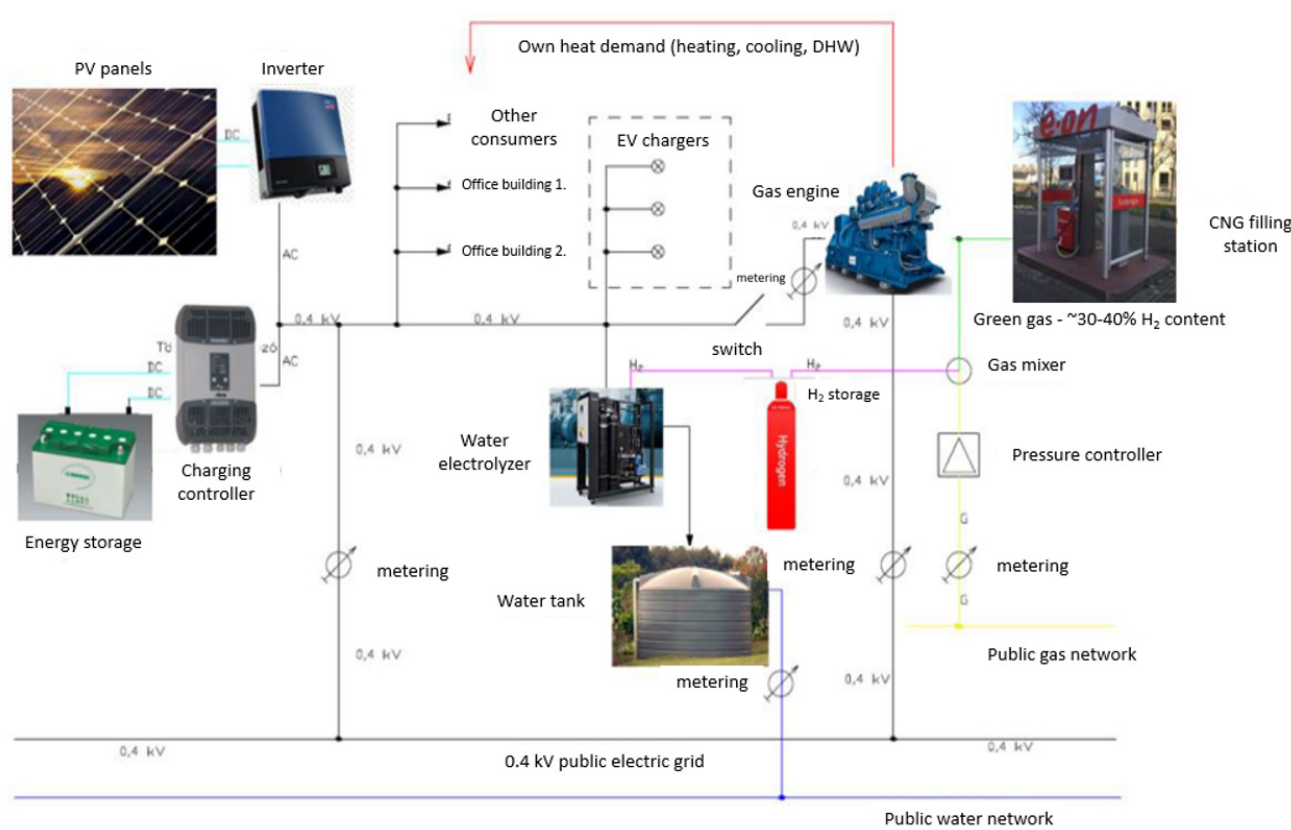
Figure 6. Suggestion for the sketch of the project.